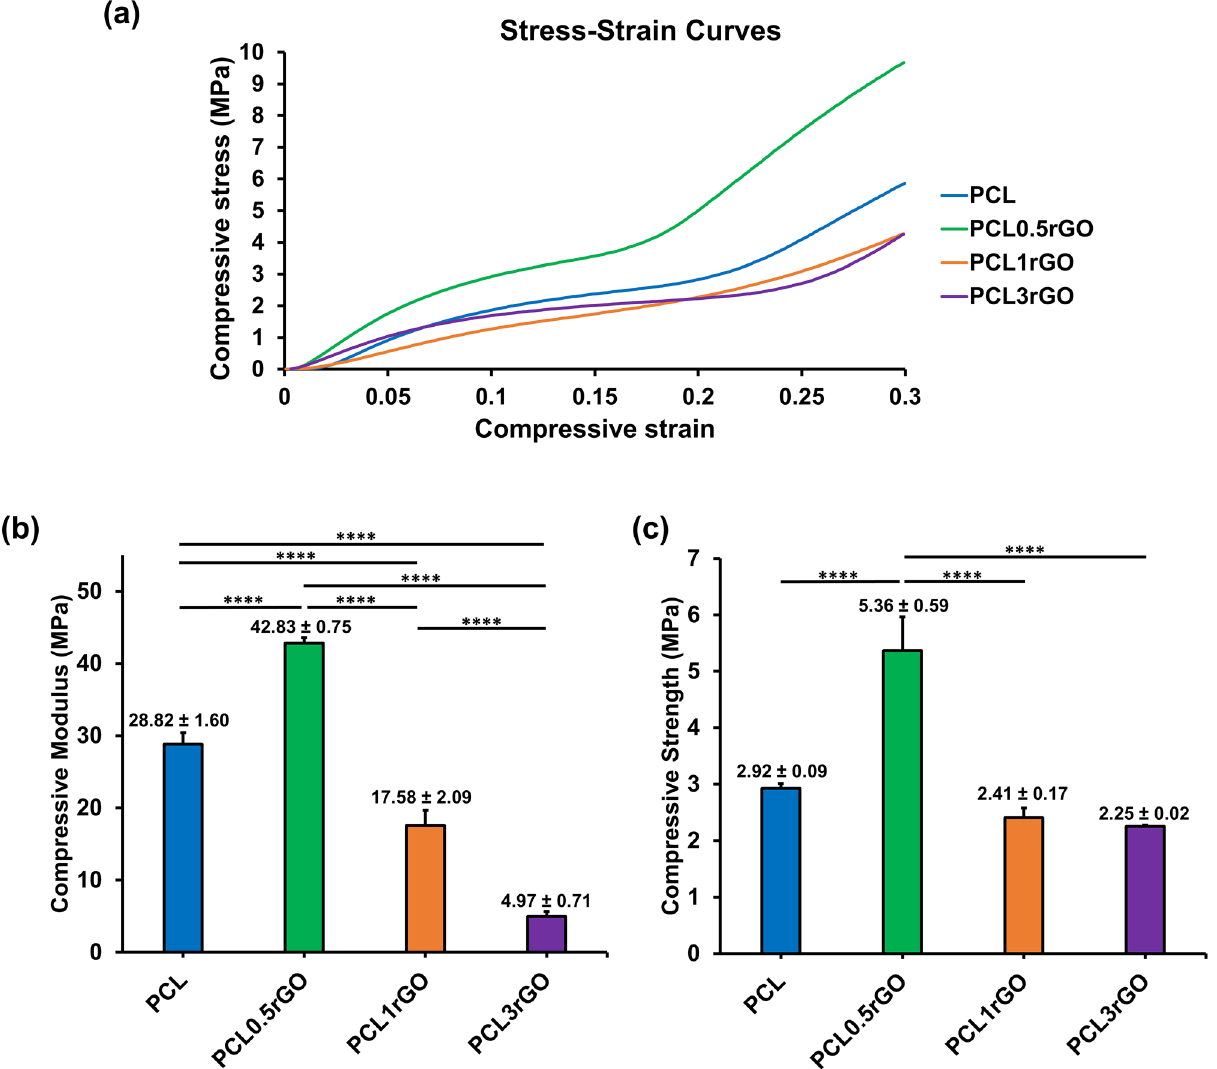
Figure 6. Mechanical analysis of the 3D printed scaffolds. ( a ) The representative stress–strain curves of the 3D printed scaffolds under uniaxial compression loading. ( b ) The compressive moduli and ( c ) compressive strength of the 3D printed scaffolds. Results are presented as mean ± SD (n = 4) (****p < 0.0001).